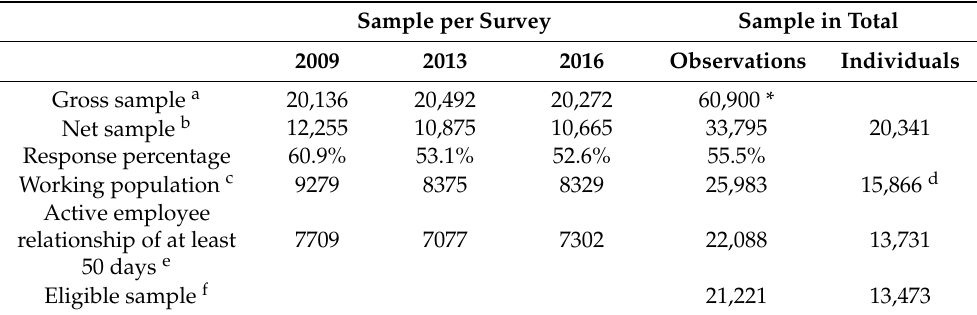
Table 1. Description of the